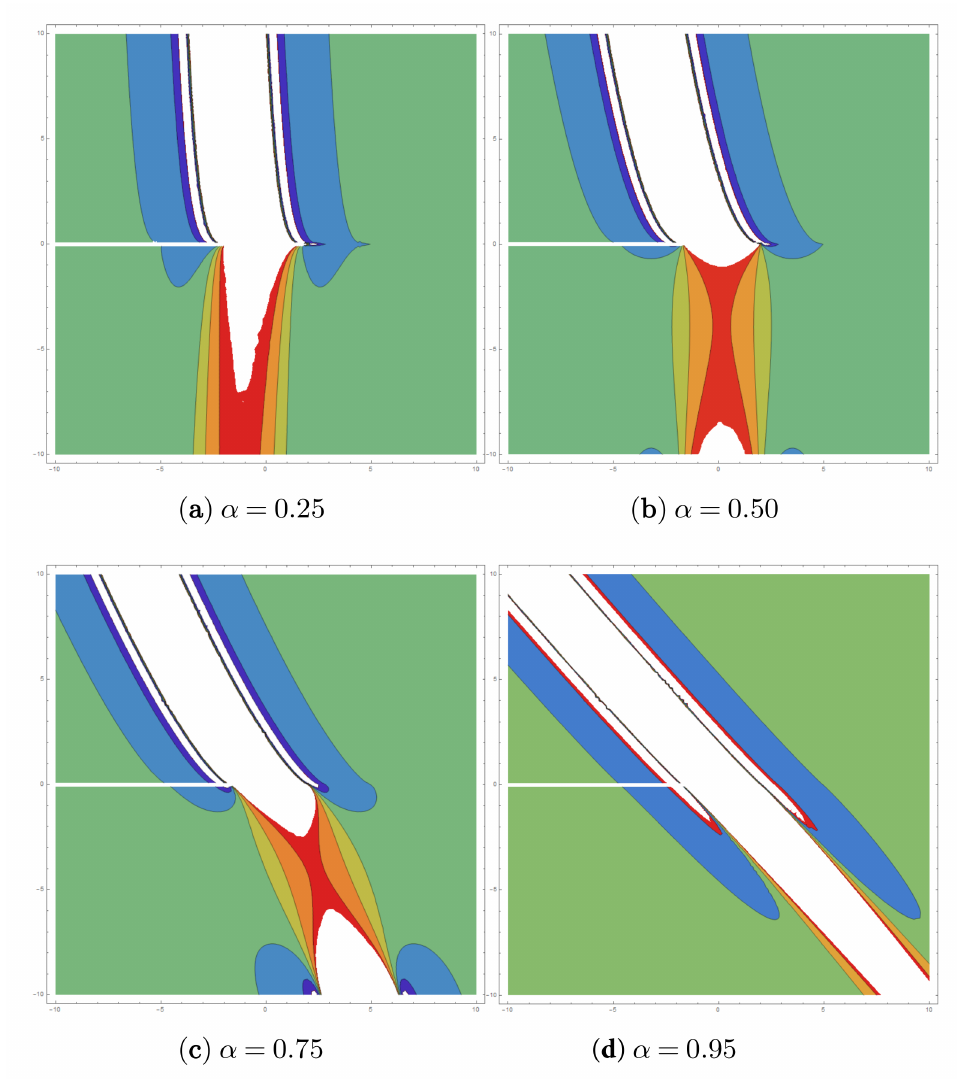
Figure 7. The 2D-contour graphs for S 2